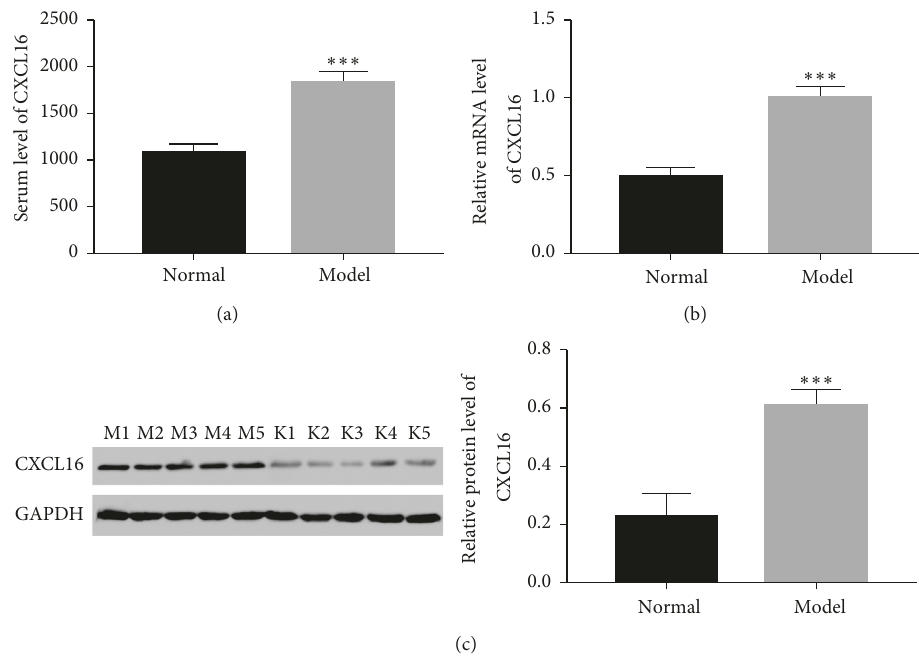
Figure 3: The level of CXCL16 was increased in mice PF model. (a) The serum level of CXCL16 was upregulated in the mouse PF model group ( ∗∗∗ p < 0 . 001 vs Normal). (b, c) mRNA and protein levels of CXCL16 were upregulated in lung tissues of PF model mice, respectively ( ∗∗∗ p < 0 . 001 vs Normal). M, the model mice that were treated by bleomycin; N, the normal mice treated by sterile saline.